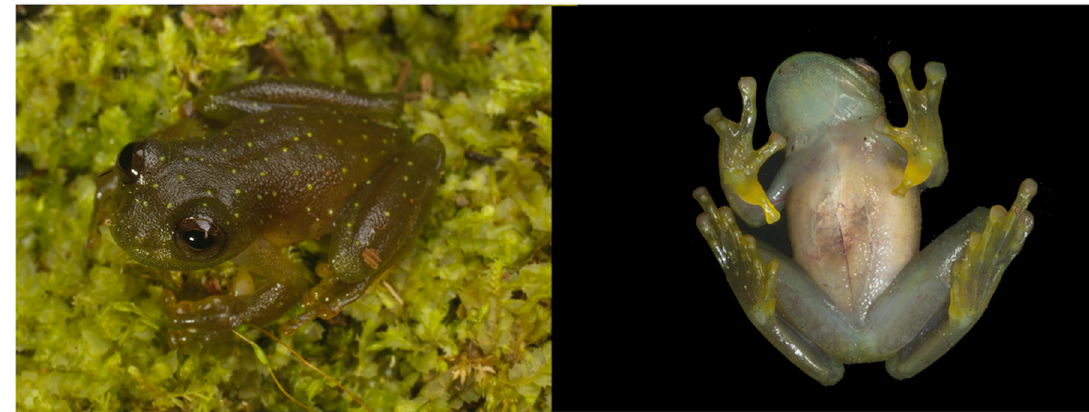
Figure 196. Rulyrana mcdiarmidi in life. Adult (QCAZ 32265) from 7.6 km W of 9 de Octubre, 1715 m, Morona Santiago province, Ecuador. Photos by Martín Bustamante.